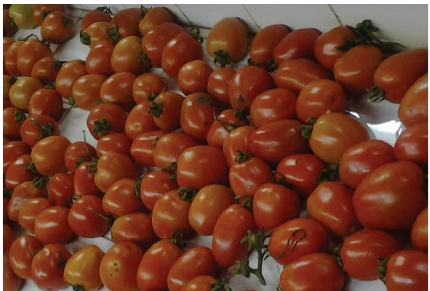
Figure 2: Red ripe tomato